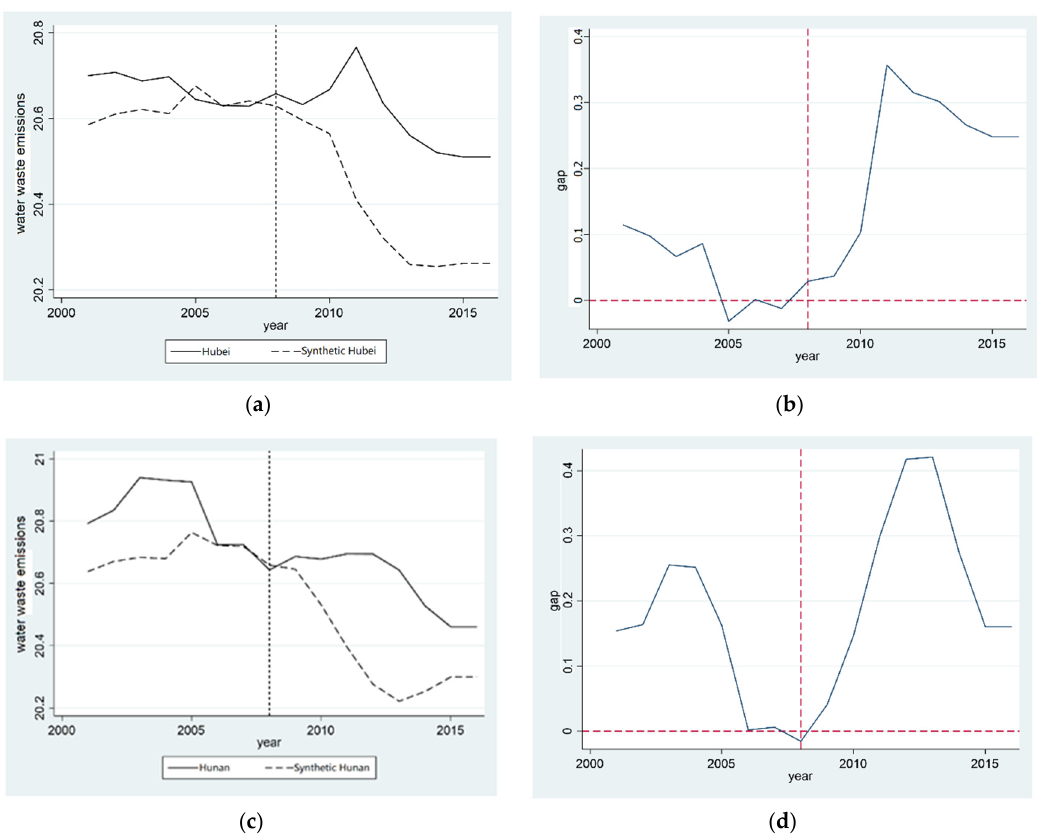
Figure 2. Comparison of total reduction effect of industrial wastewater emissions in provinces established in the “two-oriented society” pilot zone. ( a ) Comparison of wastewater reduction in Hubei; ( b ) Gap in wastewater in Hubei; ( c ) Comparison of wastewater reduction in Hunan; ( d ) Gap in wastewater in Hunan.